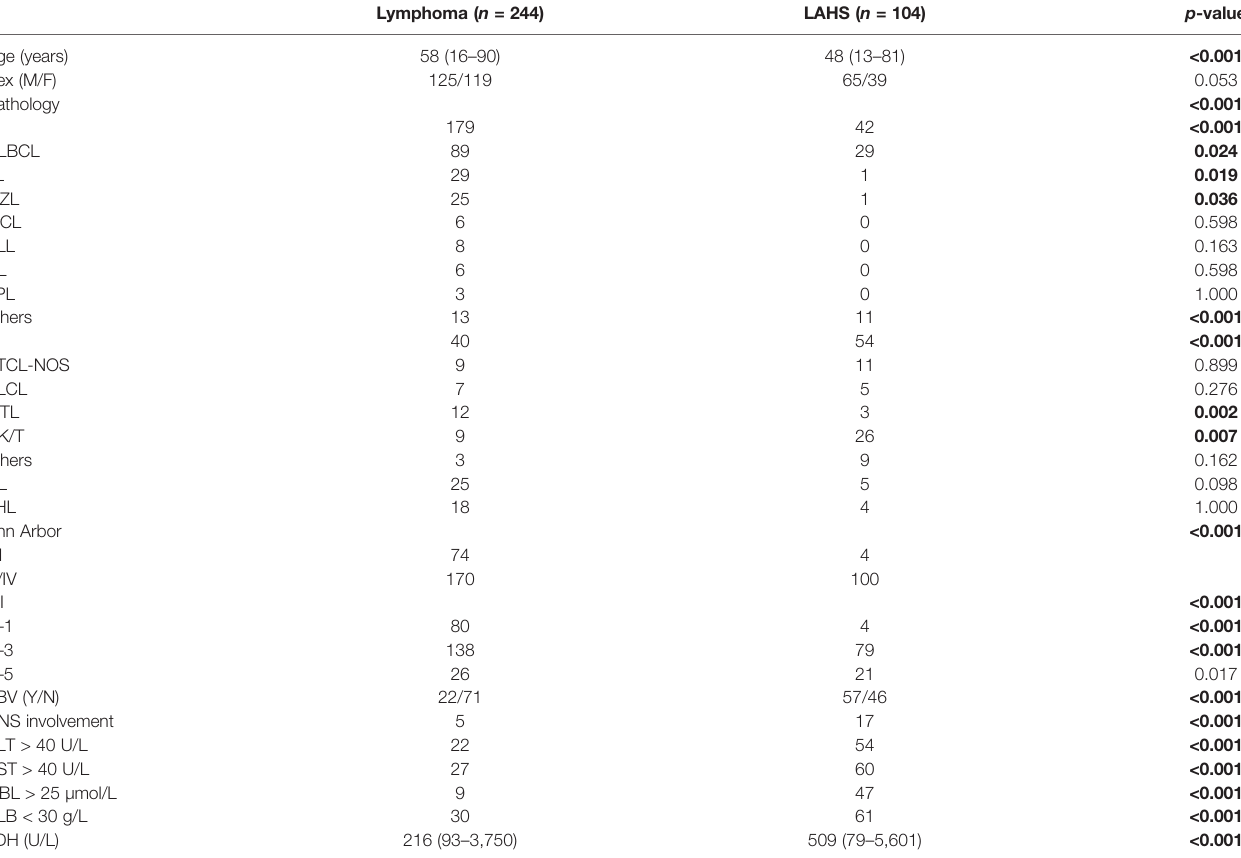
DLBCL, diffuse large B-cell lymphoma; FL, follicular lymphoma; MZL, marginal zone lymphoma; SLL, small lymphocytic lymphoma; MCL, mantle cell lymphoma; BL, Burkitt lymphoma; LPL, plasma cell lymphoma; PTCL-NOS, peripheral T-cell lymphoma, not otherwise speci fi ed; ALCL, anaplastic large-cell lymphoma; AITL, angioimmunoblastic T-cell lymphoma; cHL, classicHodgkinlymphoma;IPI,internationalprognosticindex;EBV,Epstein – Barrvirus;CNS,centralnervoussystem;ALT,alaninetransaminase;AST,aspartatetransaminase;TBIL,total bilirubin; ALB, albumin; LDH, lactate